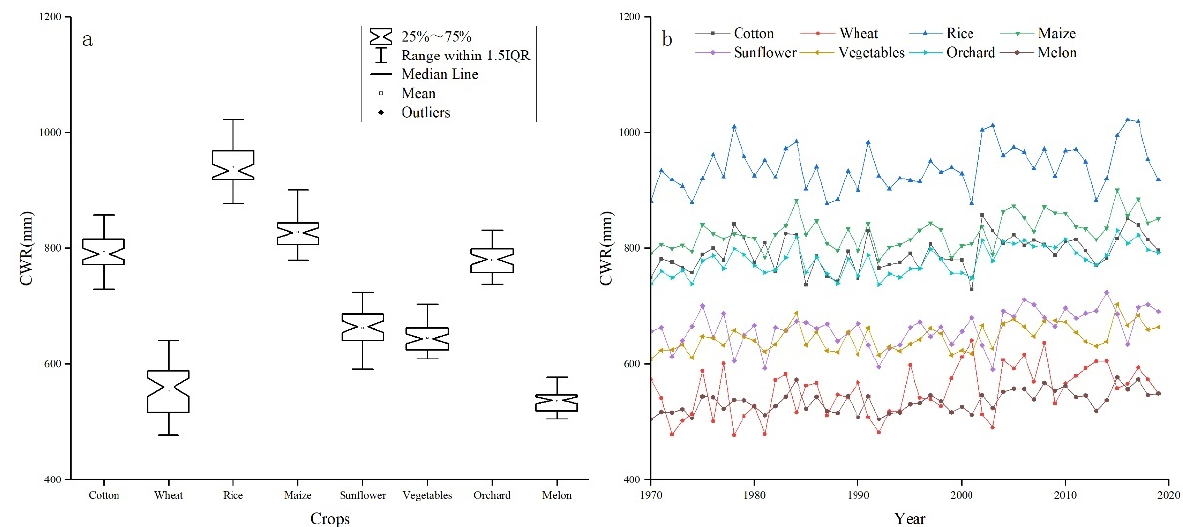
Figure 4. Crop water requirement for main crop types during the 1970s to the 2010s. Notes: ( a ) Distribution of CWR for crops; ( b ) The CWR temporal evolution for each crop.